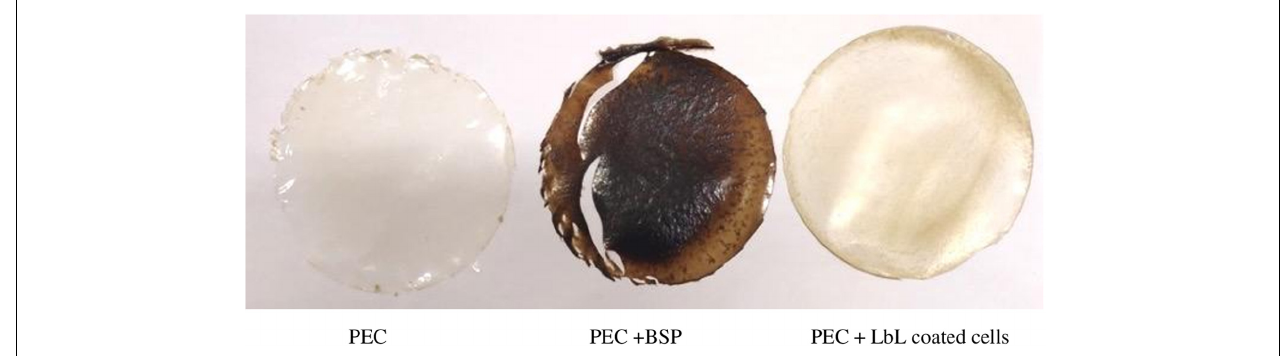
FIGURE 9 | Images of pectin films (plain = PEC), with (BSP) or with LbL coated L. rhamnosus. cells were coated with BPS/ inulin then used as part of pectin film. LbL containing film was superior over PEC+BSP in terms of handling and brittleness.